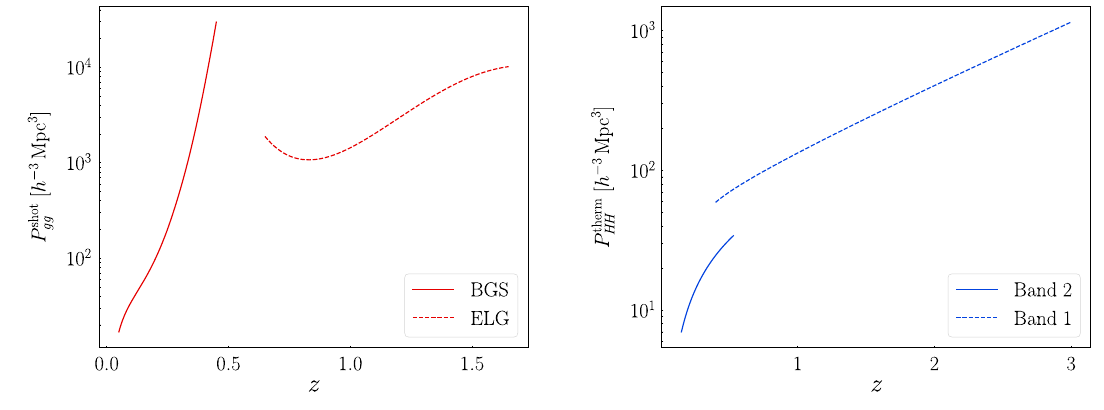
Fig. 2 Shot noise for galaxy surveys (left) and thermal noise for IM surveys (right)